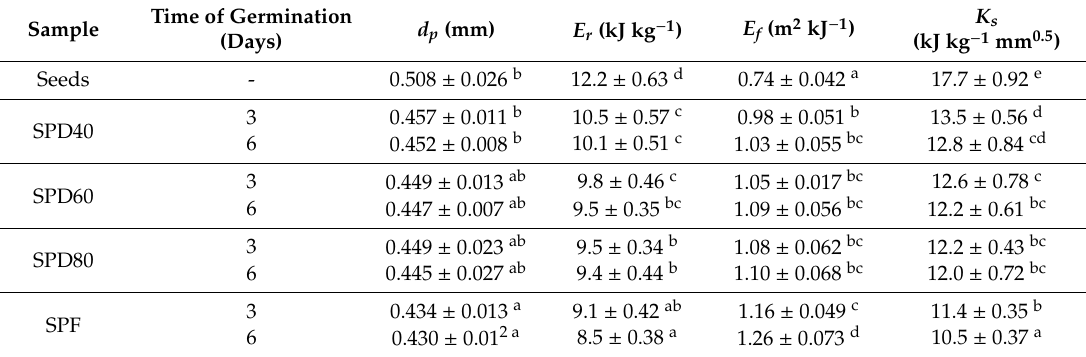
Table 3. Average particle size (d) and grinding energy indices of ground broccoli seeds and sprouts.